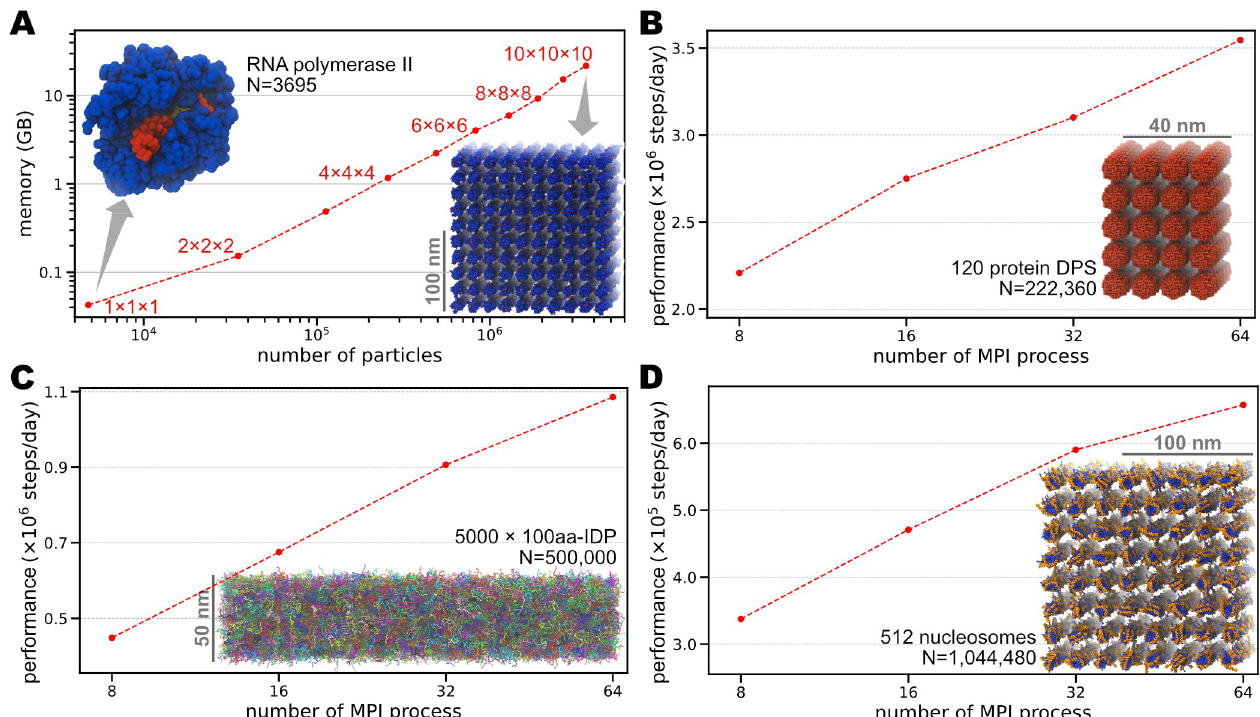
Fig 4. Benchmark of the GENESIS CG simulations. (A) Memory benchmark of the RNA Polymerase II (PolII) systems. A single PolII has 3,695 CG particles, which is then duplicated into a n × n × n ( n = 1, ... ,10) grid space. The insets show the structure of a single PolII (left) and 1000 PolIIs (right). Protein is shown in blue, DNA in red, and RNA in yellow. (B) CPU benchmark of a system containing 120 DPS proteins. The total number of CG particles is 222,360. (C) CPU benchmark for a system of 5000 chains of 100aa IDPs. The total number of CG particles is 500,000. (D) CPU benchmark for a system including 512 nucleosomes. The total number of CG particles is 1,044,480. The insets of (B), (C), and (D) show the initial structure of each system, respectively. N represents the total number of CG particles in each system. For all the CPU benchmarks, we used 5 OpenMP threads.